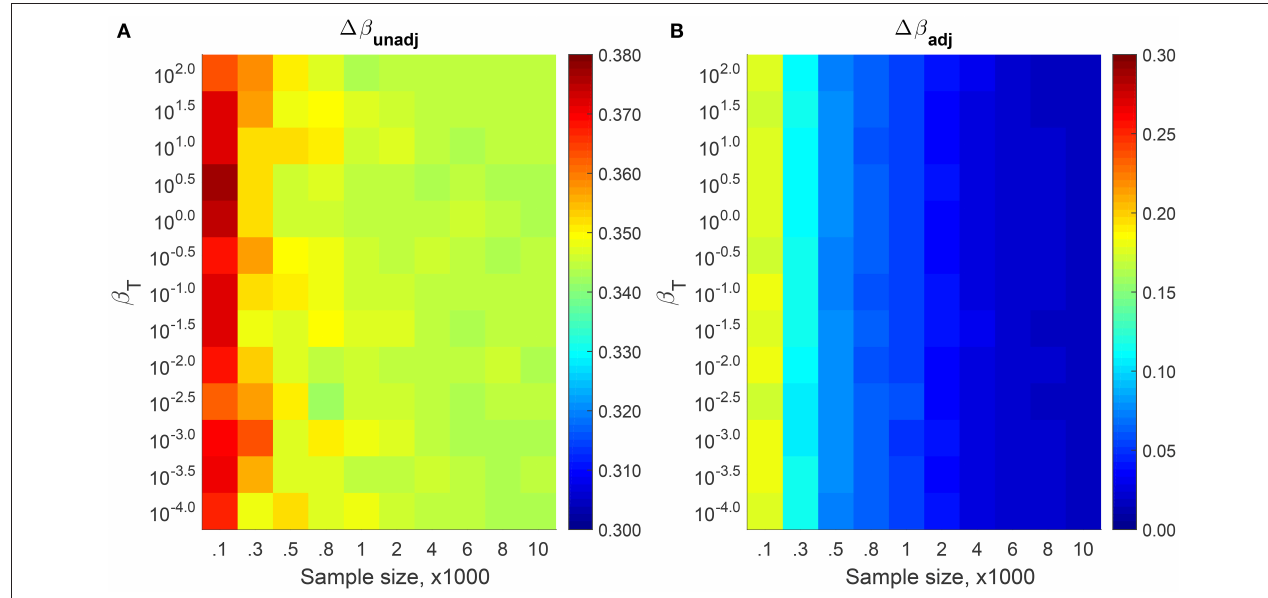
0 and = 0.1, x min 0) 0.1 [ 1 33 % ) even for large N . In ln (0.1) ] = = = − ≈